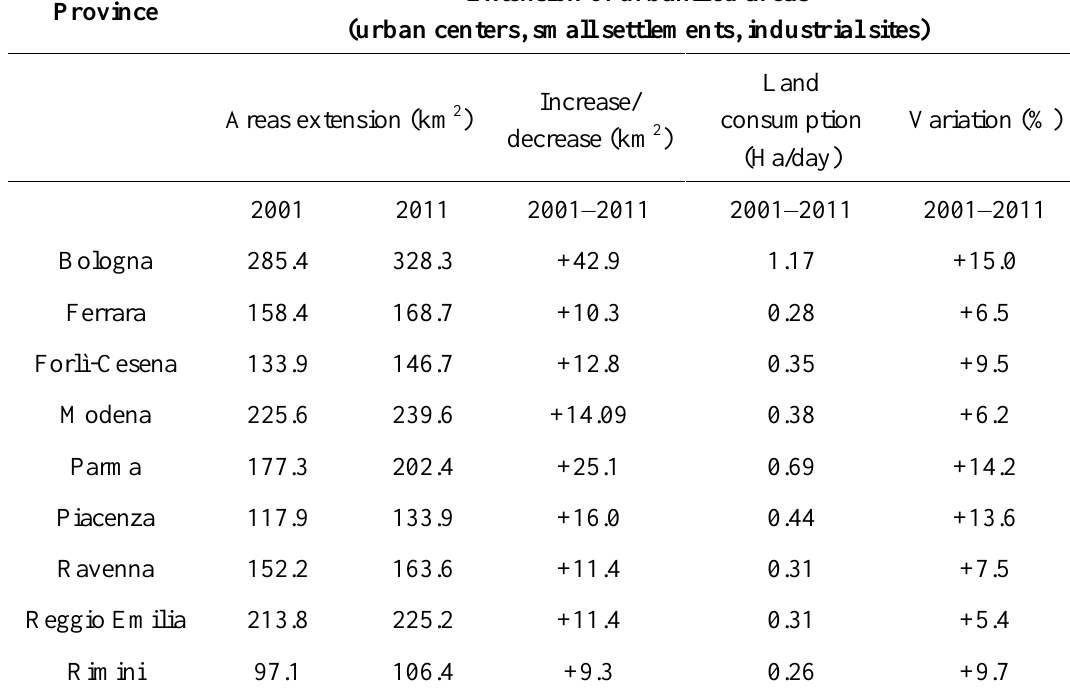
Table 4. Land consumption in Emilia-Romagna between 2001 and 2011, by Province (datasource: